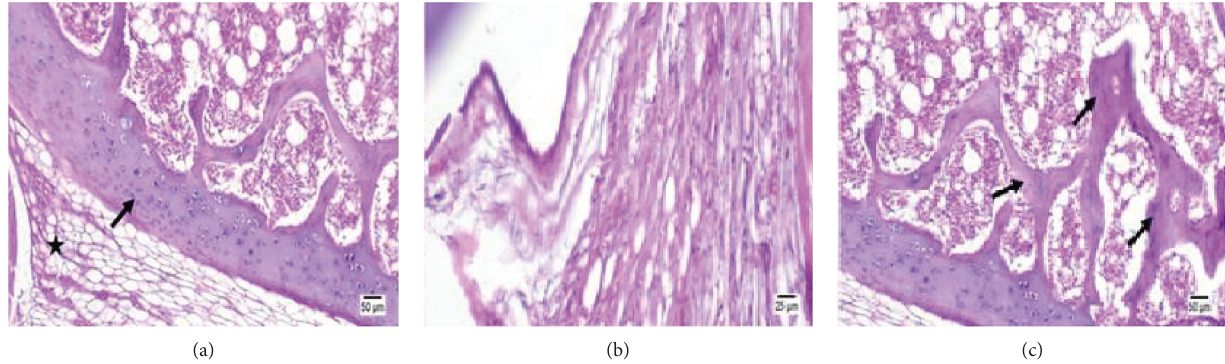
Figure 10: Group (400 ppm): (a) normal articular cartilage (arrow) and synovium (star), (b) normal joint capsule, and (c) normal trabecular bone (arrows) of the